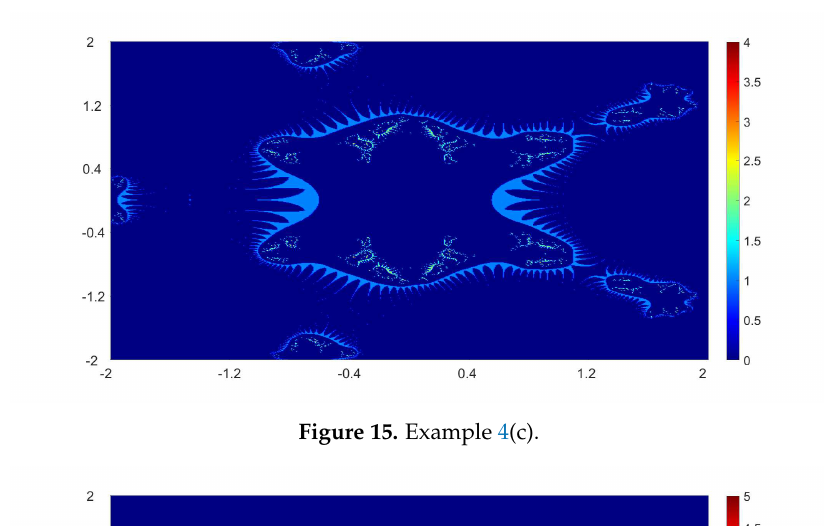
Figure 15. Example 4(c).